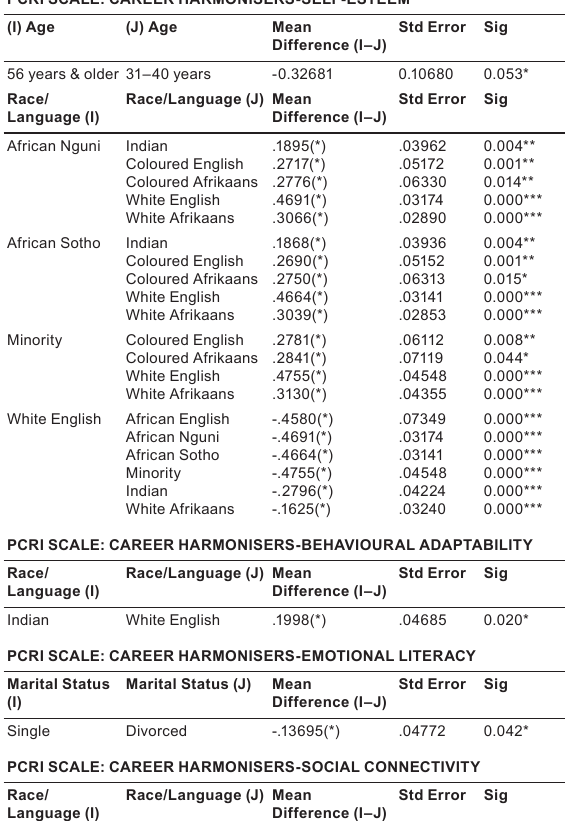
Table 10 Summary of Scheffé multiple comparison tests: Significant group mean differences on career harmonisers scale (N = 2 997) PCri sCale: Career